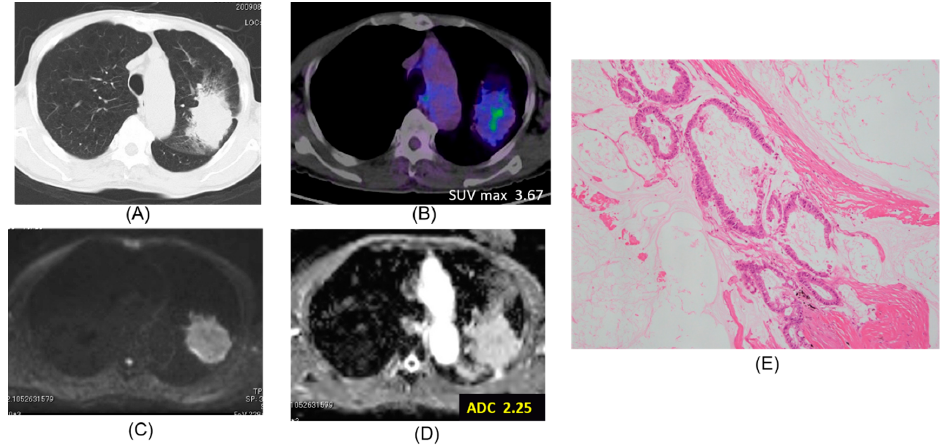
Figure 2. Mucinous adenocarcinoma. The ADC of the carcinoma was 2.25 × 10 − 3 mm 2 /s. ( A ) CT, ( B ) PET-CT, ( C ) DWI, ( D ) ADC map, ( E ) Pathology (Hematoxylin and Eosin Staining) ×100.